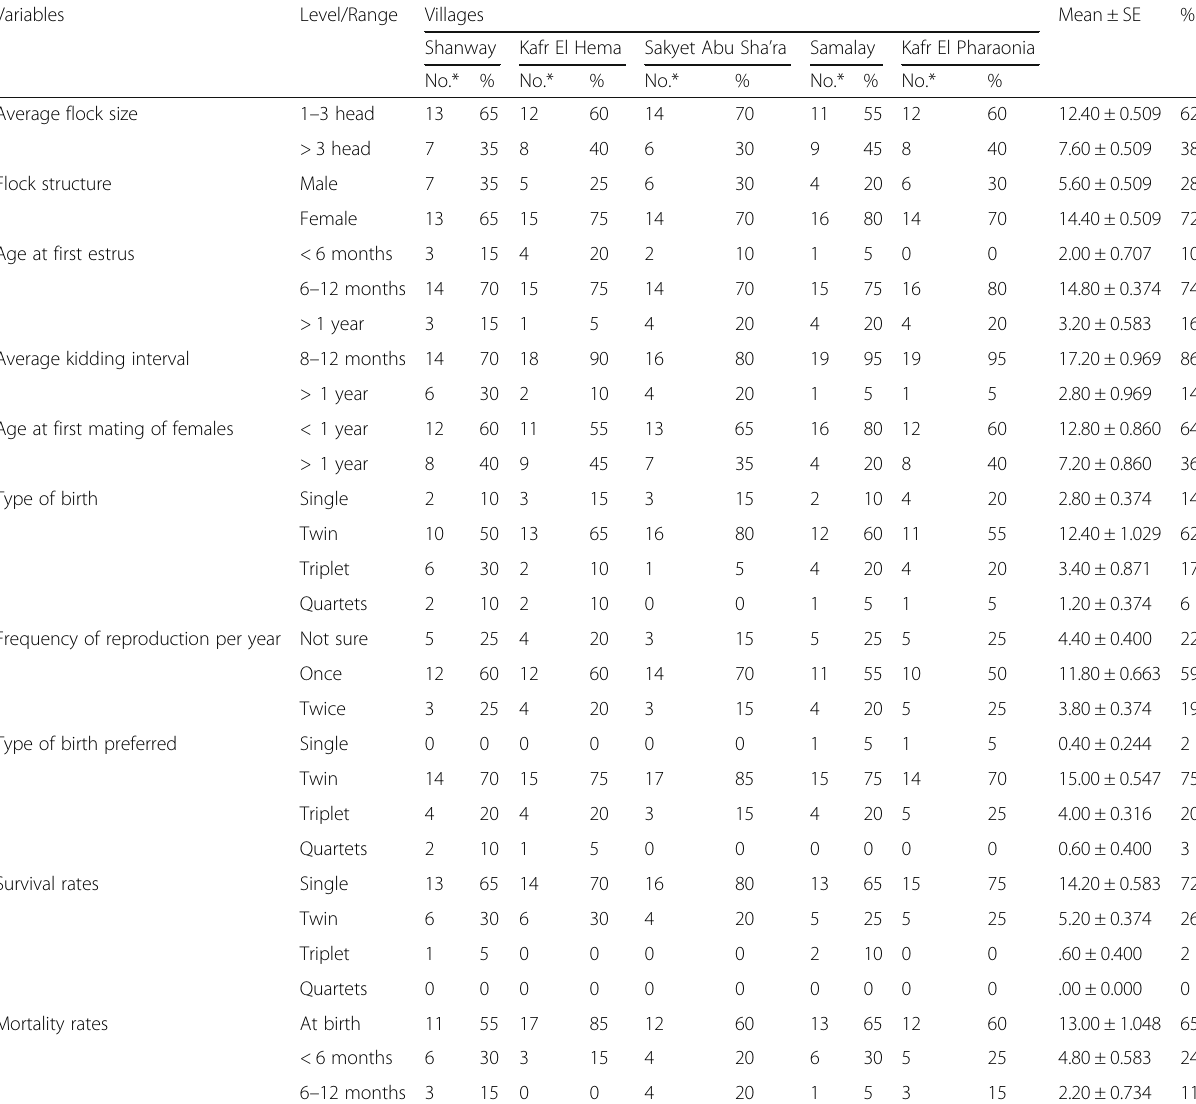
Table 3 Performance traits and characteristics of goats in rural areas of the Nile Delta in Egypt Variables Level/Range Villages